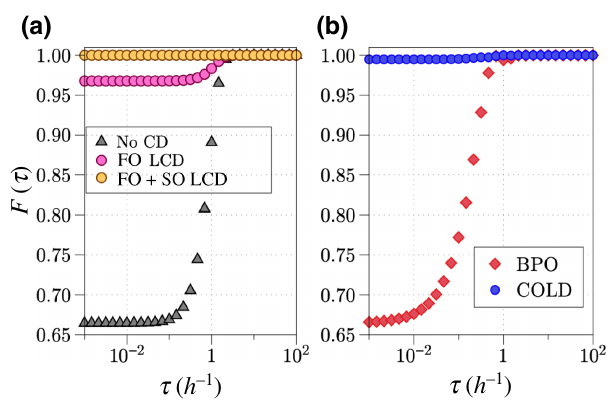
FIG. 1. Optimization of the annealing protocol for the two- spin Hamiltonian given by Eq. (11) for h / J = 2. (a) Final fidelities of the annealing protocol with triangles (black) repre- senting the case where no CD is applied and circles showing the case of first-order (FO) LCD (pink) as well as the combination of first- and second-order (SO) LCD (orange). (b) Final fidelities achieved when using the optimal control method BPO (red dia- monds) and the new approach of COLD (blue circles), both with N k =